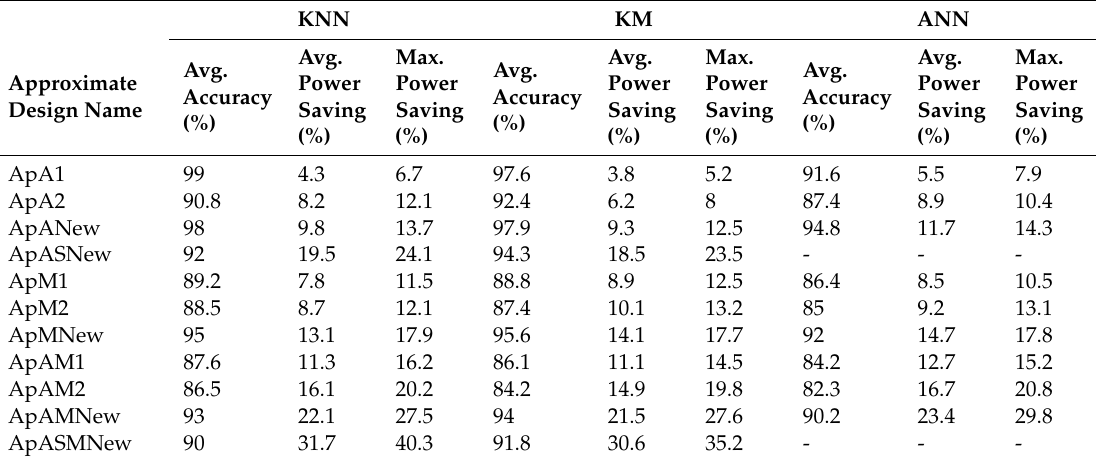
Table 4. Accuracy and power saving percentages of the approximate blocks, given as the average and maximum of the results from di ff erent datasets for each algorithm. KNN KM ANN